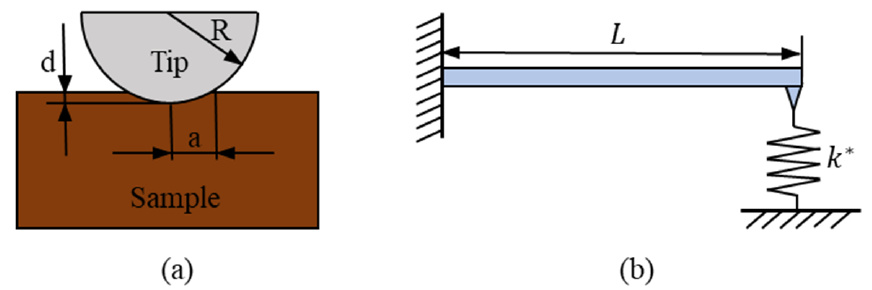
Figure 2. ( a ) The simplified model of contact between the probe tip and the sample. ( b ) The simplified model for cantilever probe in contact with sample surface.